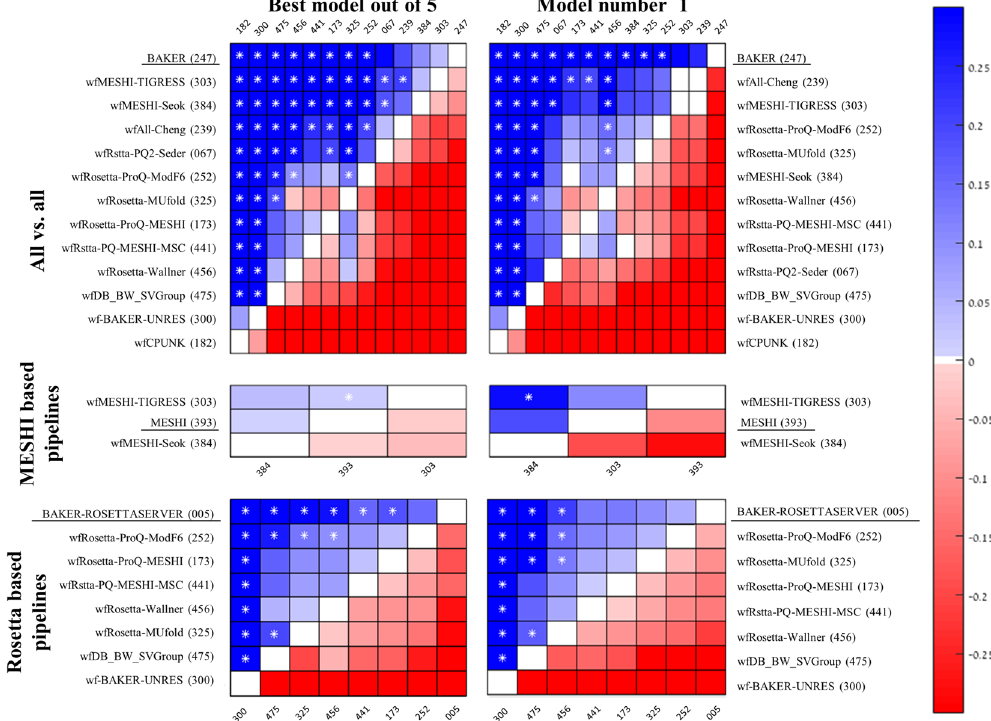
Figure 9. Pairwise comparison of WeFold and related (underlined) CASP12 groups. Each cell represents a comparison between the row and column groups, based on the subset of targets they both predicted. Cell colors depict the difference in average z-scores (GDT_TS). Blue indicate better performance of the row group. Asterisks indicate statistical significance (p < 0.05; Wilcoxon two-sided pair test). Rows are ordered by decreasing number of significant cells, and then by blue cells. Source: http://www.predictioncenter.org/casp12/